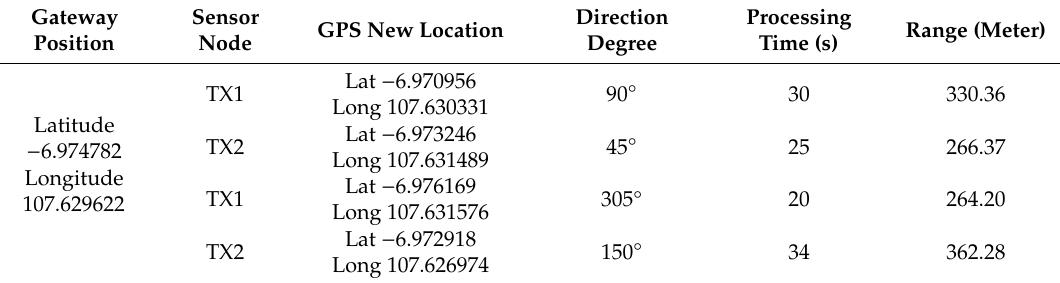
Table 3. Test Result Tracking of Proposed System at N-LoS Location (Small